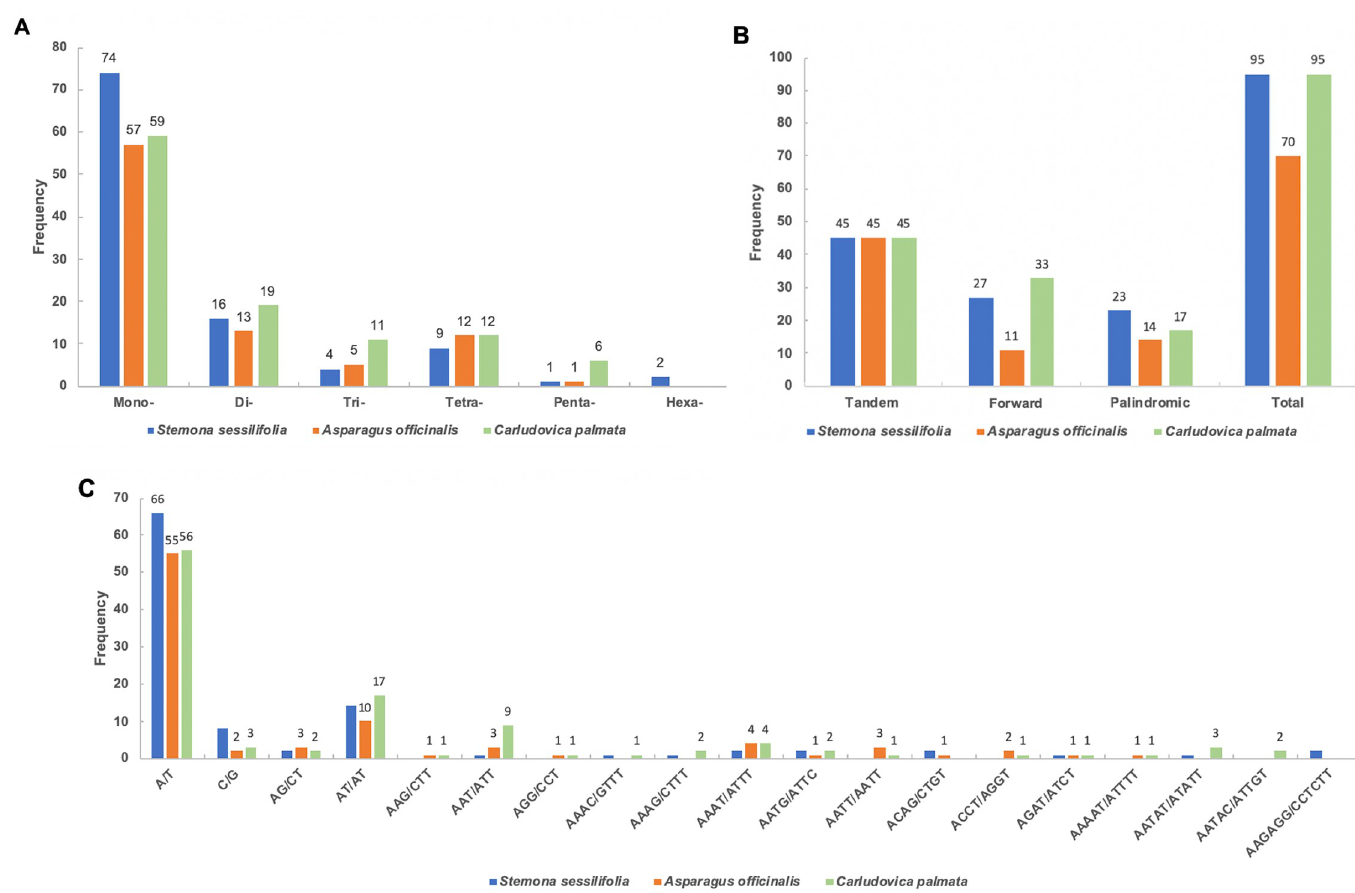
Fig 2. Simple sequence repeats (SSRs) and long repeat sequences identified in the chloroplast genomes. (A) Distribution of different types of SSRs in the chloroplast genomes. (B) Distribution of long repeat sequences in the chloroplast genomes. (C) Frequency of SSR motifs in different repeat class types.